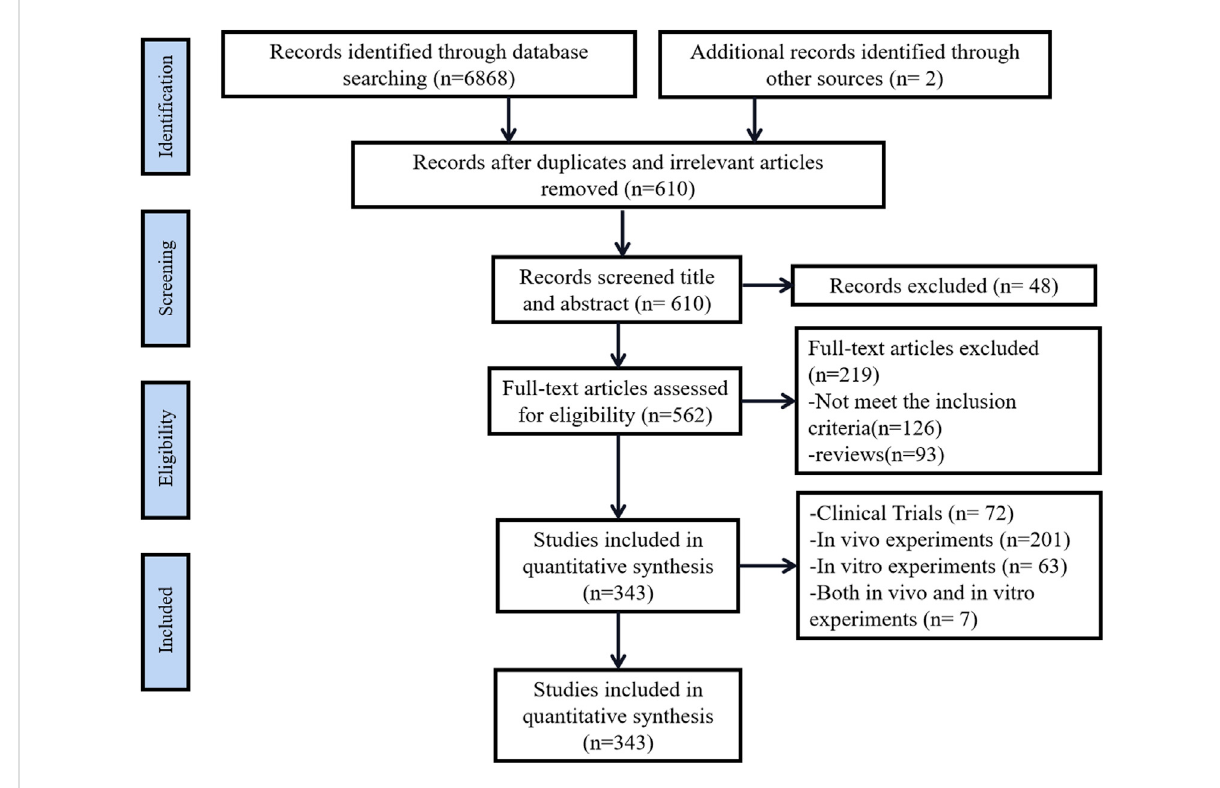
FIGURE 1 Summary of the literature search